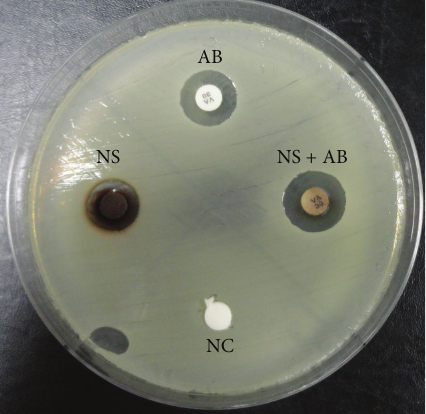
Figure 6: Zone of inhibition of silver nanoparticles produced by SHE against vancomycin resistant MRSA isolates collected from diabetic foot ulcer patients. NS: silver nanoparticles, AB: antibiotic of choice (vancomycin), NS + AB: silver nanoparticles and van- comycin, and NC: negative control.